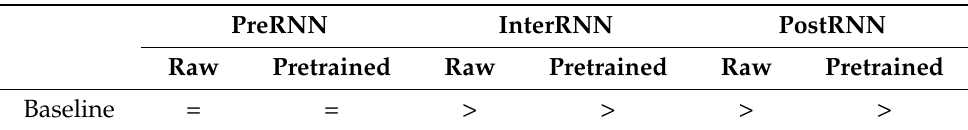
Table 5. Statistical improvement over the base neural model of the different proposed schemes considering the Wilcoxon signed-rank test with a significance value of p < 0.05 for the symbol error rate metric. The symbols = and > represent that the error of the method in the row (the base neural architecture) is not significantly different or is significantly greater than that of the column, respectively. PreRNN InterRNN PostRNN Raw Pretrained Raw Pretrained Raw Pretrained